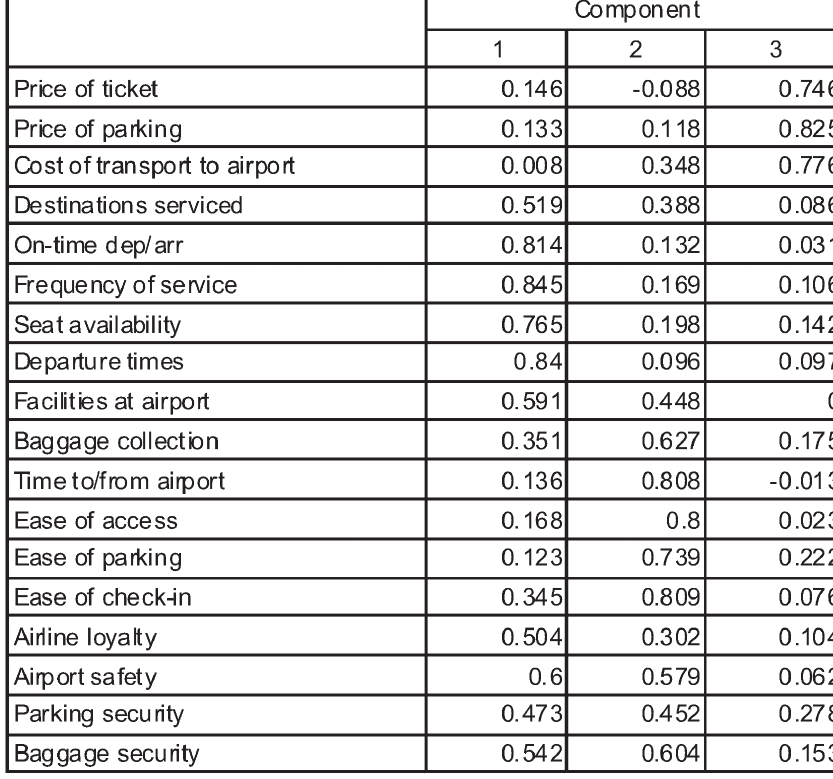
Table 8: Confirmatory factor analysis (three